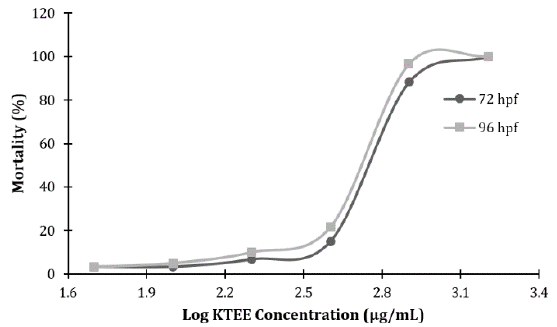
Figure 1. Relationship of concentration